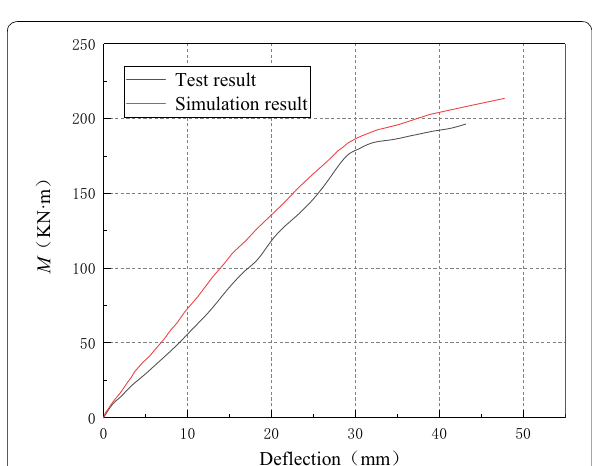
Fig. 25 Residual flexural capacity of the L5 beam after 1 h of fire exposure